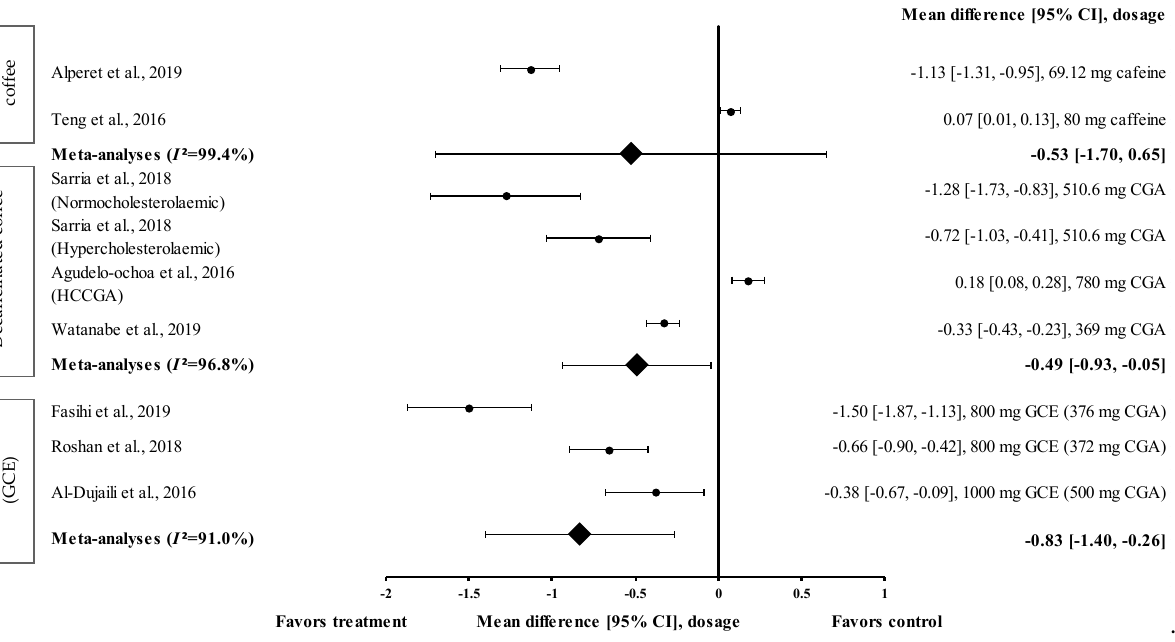
Figure 7. Forest plot showing the effect of caffeinated coffee, decaffeinated coffee, and GCE supplements on DBP, expressed as mean differences between the values obtained in the intervention and control groups. A negative effect size indicates that caffeinated coffee, decaffeinated coffee, and GCE supplements reduce DBP. Meanwhile, a positive effect size indicates that caffeinated and decaffeinated coffee increase DBP. Horizontal lines represent 95% CIs. Diamonds represent the pooled effect size from random effects analysis. CGA: chlorogenic acid, CI: confidence interval, GCE: green coffee extract, DBP: diastolic blood pressure, HCCGA: high CGA content, MCCGA: medium CGA content. The values ± 0.2, ± 0.5 and ± 0.8 represent small, medium, and large effect sizes [22,24–27,30,31,33].